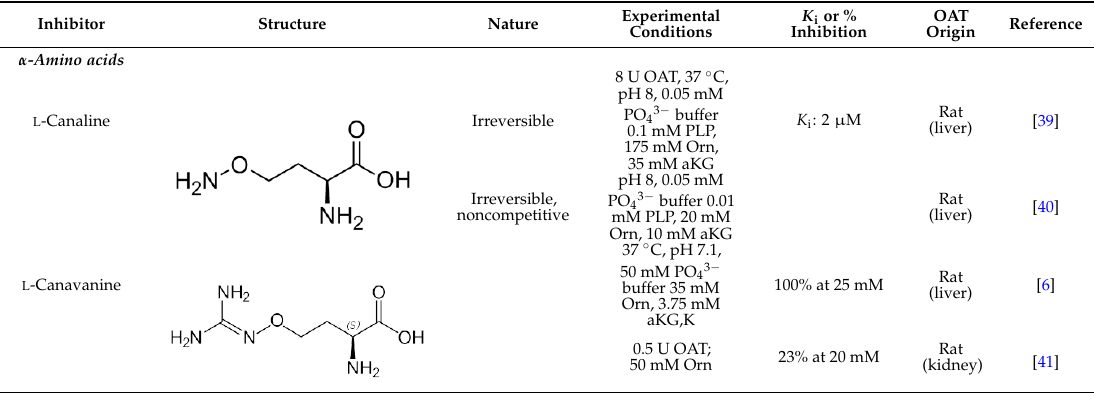
Table 2. OAT inhibitors described for mammalian enzyme.